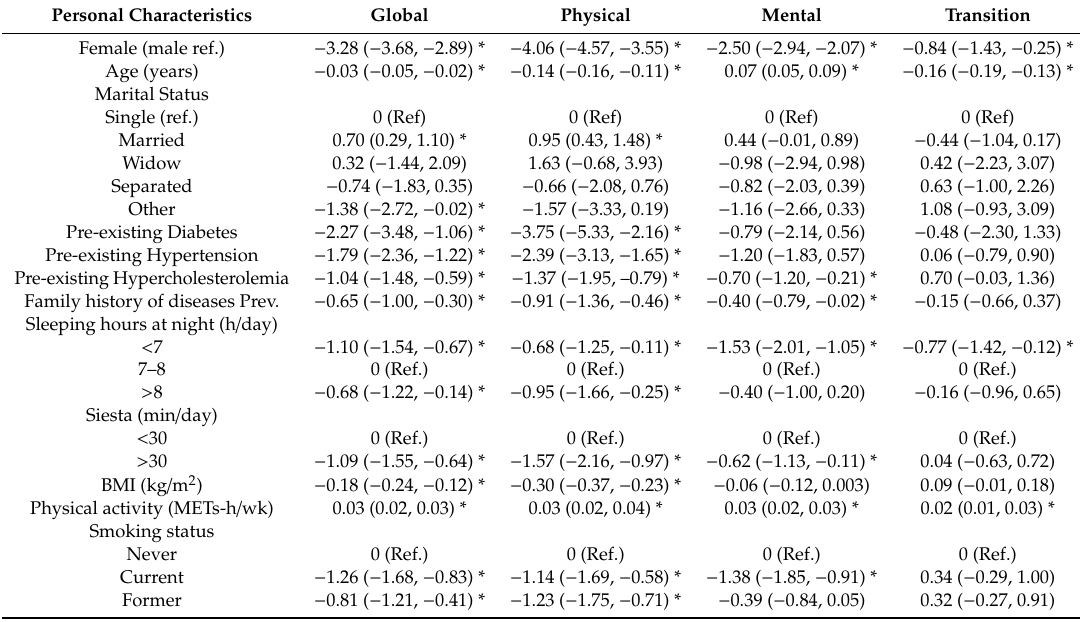
Table 3. Multivariable regression models with β -coe ffi cients (95% CI) of lifestyle characteristics for each of the SF-36 questionnaire summary component scales. Personal